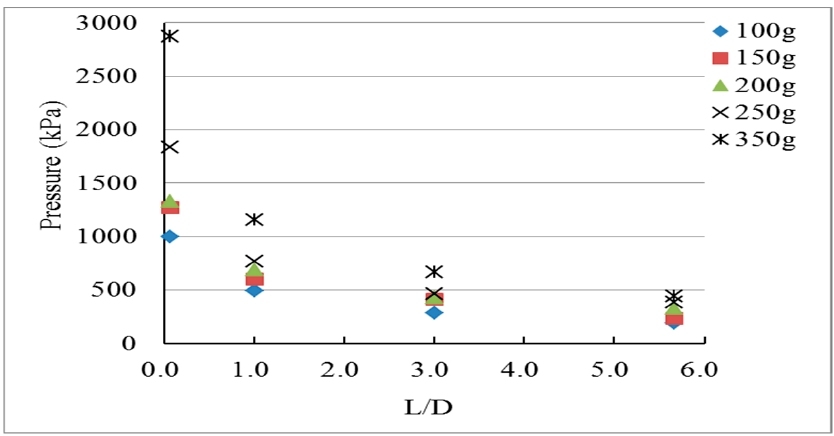
Figure 5. Comparison diagram of explosion experiment results of linear tunnel with expansion chamber.